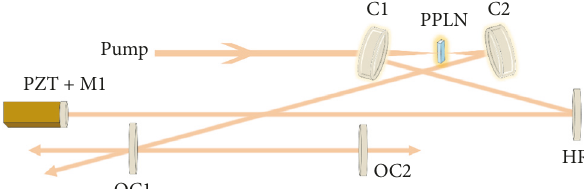
Figure 1: The sketch for the experimental setup of the degenerate OPO. C1 and C2: concave mirrors with ROC of 150 mm; HR: flat mirror with high reflectivity; M1: sliver mirror; PZT: piezo translator; OC1 and OC2: output couplers.